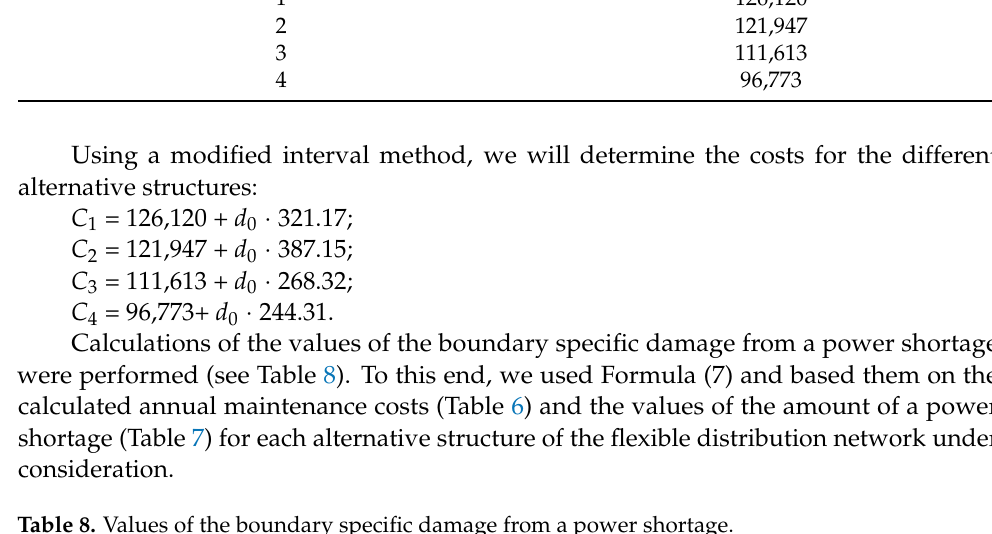
Table 8. Values of the boundary specific damage from a power shortage. Alternatives Being